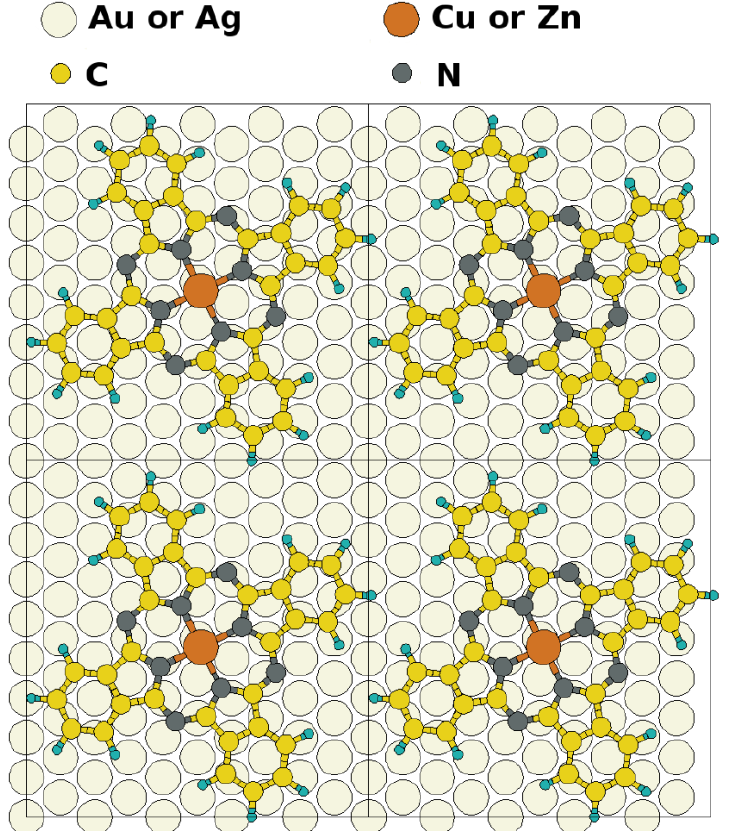
Figure 1. Schematic representation of the considered metal/MePc interfaces. The unit cell used in the simulations is